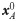
General numeric solution.Top: original image xA0 (picture of the corresponding author taken by Virginia Amblar). Central row: extreme images (MAD best and worst -left and right-) with the same RMSE than the white-noise corrupted image at the center. The central image is the initial random selection in the sphere of constant RMSE. Extreme images were computed using the gradient descent/ascent described in Eq 44 (i.e. require Result I). The fact that these extreme images are visually better and worse than the central image indicates that the theory works. Bottom row: isolated distortions of the same energy: Δx0=xA0-xMAD0 versus the initial white noise.